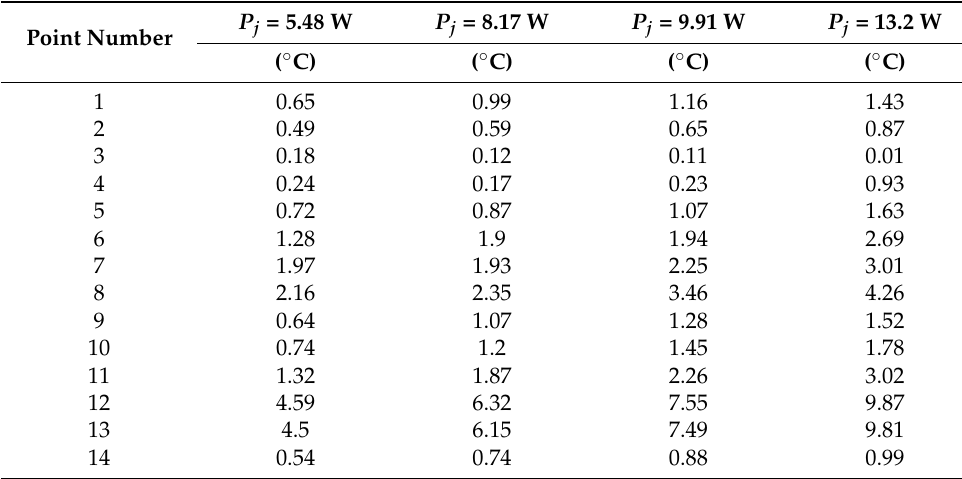
Figure 6. Temperature distribution on the case for P j = 13.2 W; ( a ) temperature distribution on the external surface of the case, ( b ) temperature distribution on the internal surfaces of the case. The obtained values of the differences between the simulated die temperature and the casing point (Figure 1) are presented in Table 6. Table 6. Differences between the die temperature and the temperature of individual points on the case—the results were obtained on the basis of the simulation.